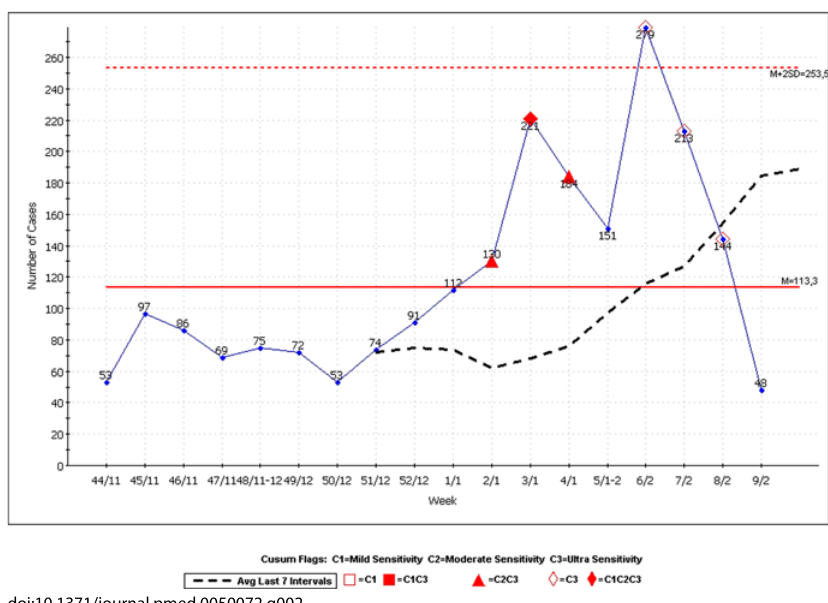
Figure 2. Post-Flooding Diarrhea Outbreak in Jakarta, Indonesia, January–February 2002 X -axis labels are week/month, from the 44th week of 2001 (in November) to the 9th week of 2002 (in February). The blue line shows the number of cases per week reporting to an EWORS site in Jakarta with watery diarrhea and dehydration, fever, or vomiting. The “Cusum” (cumulative sum) C1, C2, and C3 alerts identify, with increasing sensitivity, significant increases in case counts using the Early Aberration Reporting System [27]. The horizontal red solid and broken lines represent the long-term mean and mean plus two standard deviations (sometimes used as an outbreak detection threshold in other surveillance systems),